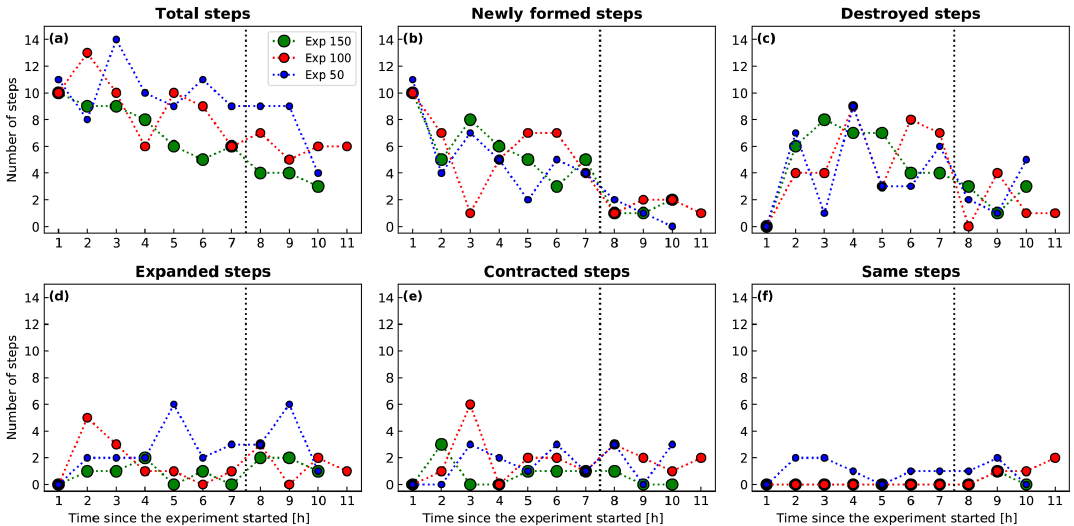
Figure 7. Step activity in the feed experiments expressed as number of (a) total steps, (b) newly formed steps, (c) destroyed steps, (d) steps that have expanded, (e) steps that have contracted, and (f) steps that remained the same. The vertical dashed line separates the feed periods (on the left) from the no-feed periods (on the